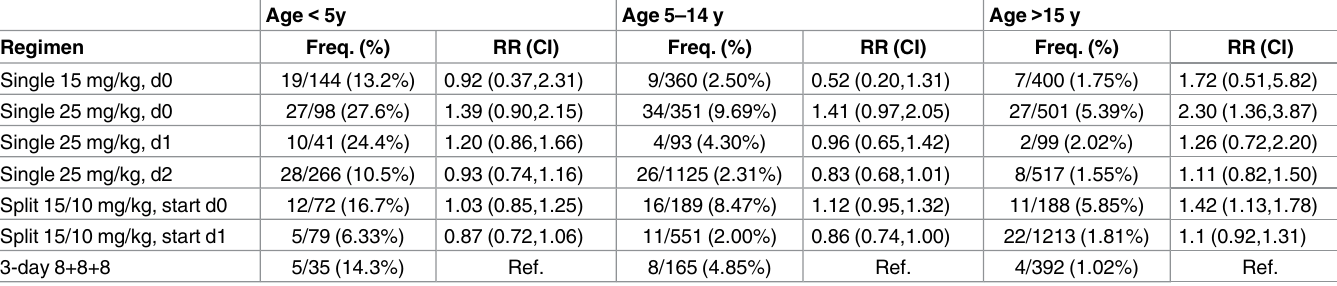
All treatments are compared with the ‘8+8+8’ MQ regimen (8 mg/kg MQ administered on three subsequent days). Early vomiting was defined as vomiting occurring within one hour of MQ treatment. The unit of analysis was by patient, i . e ., if a patient vomited on all three days of treatment with 8+8+8, this was counted only once. Risks and confidence intervals were estimated using Poisson regression with robust error variances.